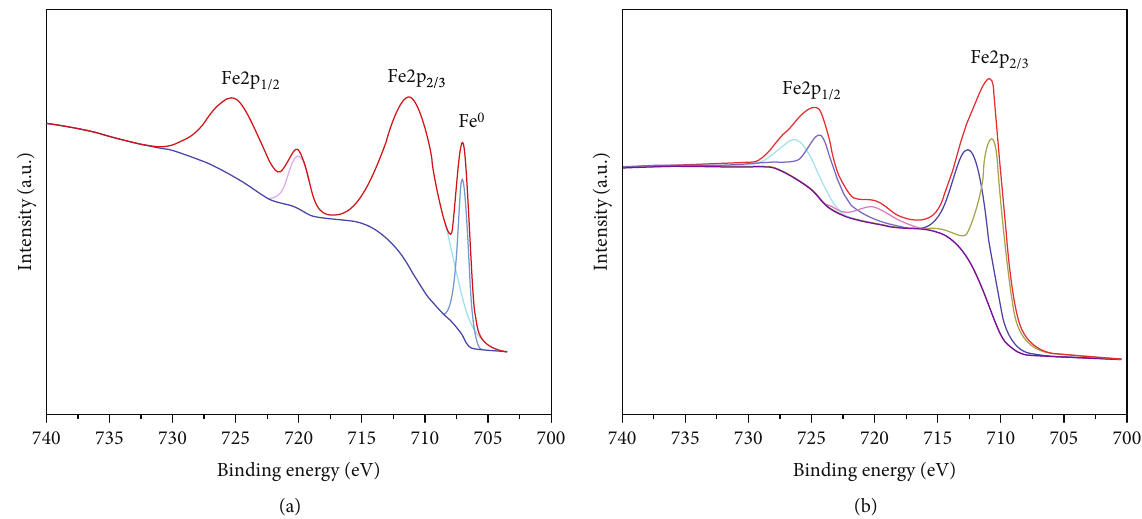
Figure 3: X-ray photoelectron spectroscopy spectra (a) before and (b) after NO iron-coated